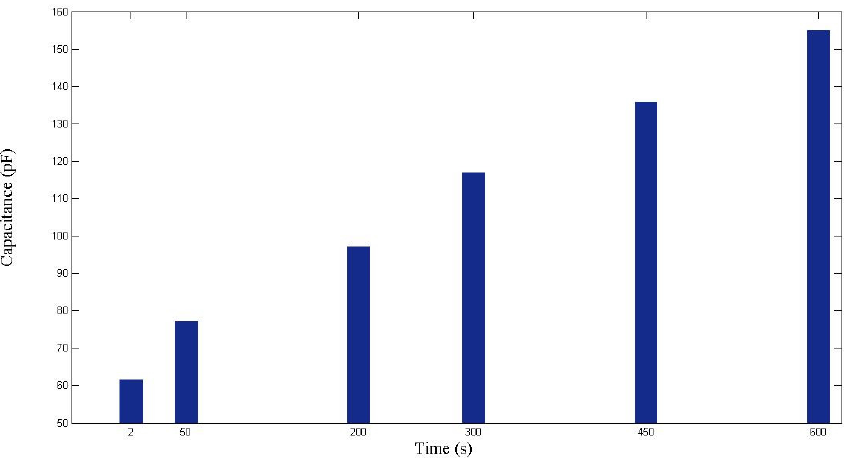
Figure 12. Capacitance measured during the second RTM experiment using a nine-layer fiber pre- form.